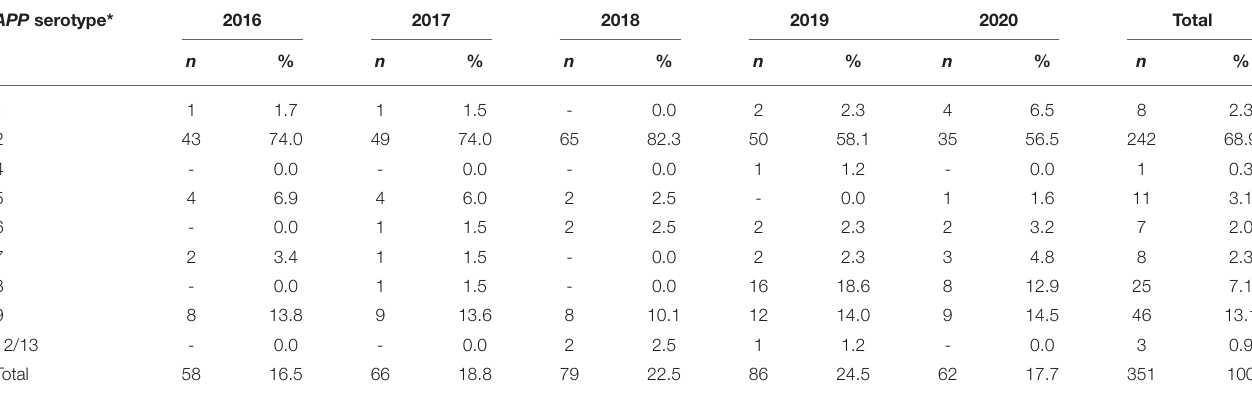
TABLE 1 | Serotype distribution of 351 typable A. pleuropneumoniae isolates defined by toxin gene pattern and slide agglutination in the years 2016–2020. APP